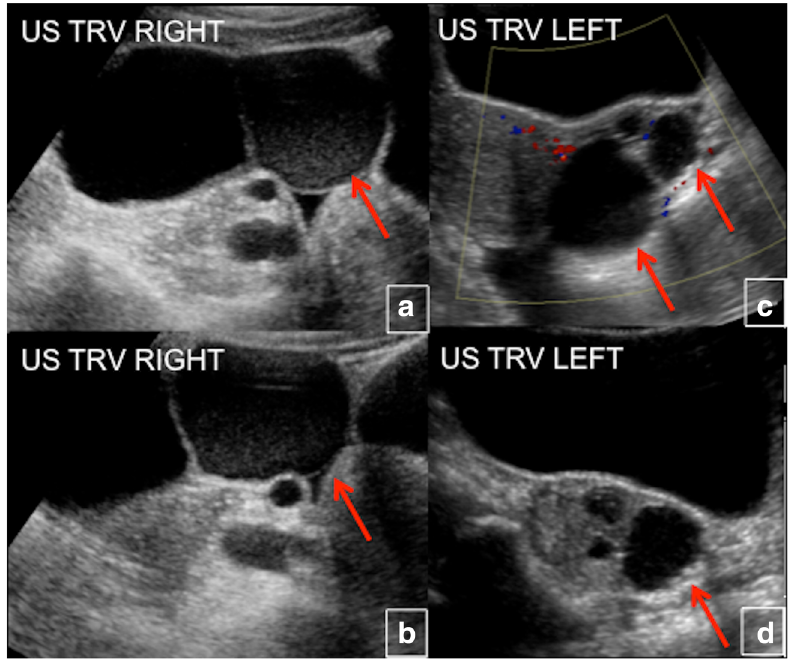
Fig. 24 a-d Bilateral ovarian cysts in McCune-Albright syndrome ( red arrows